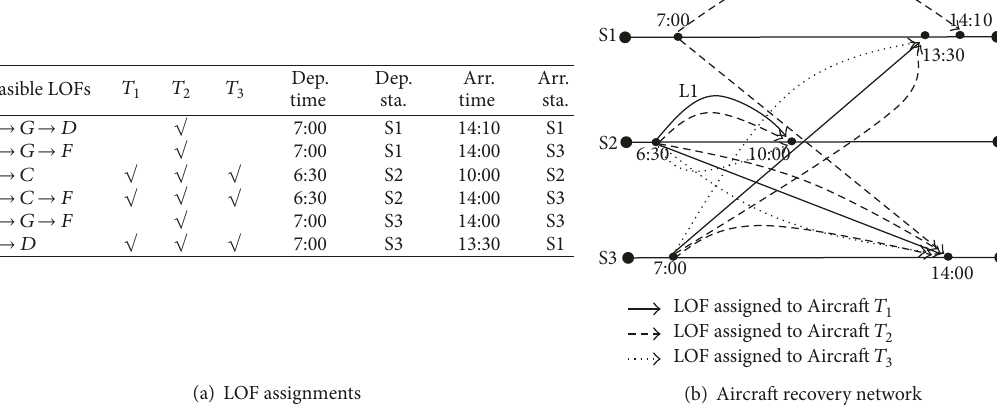
Figure 4: Aircraft recovery network: (a) LOF assignments and (b) aircraft recovery network for Aircraft 𝑇 1 , 𝑇 2 , and 𝑇 3 .